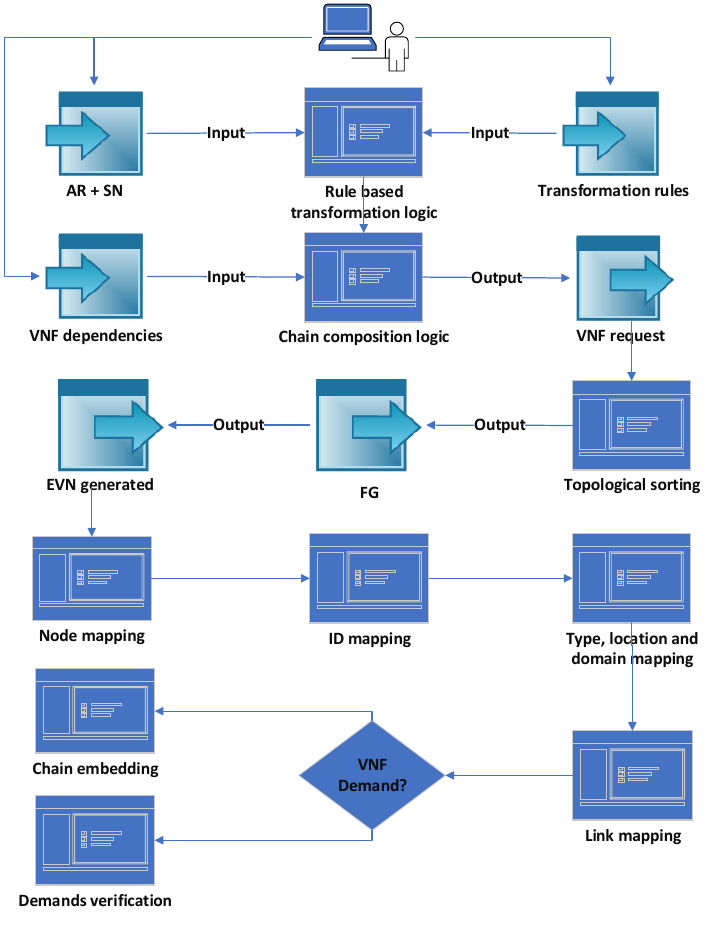
Figure 2. System